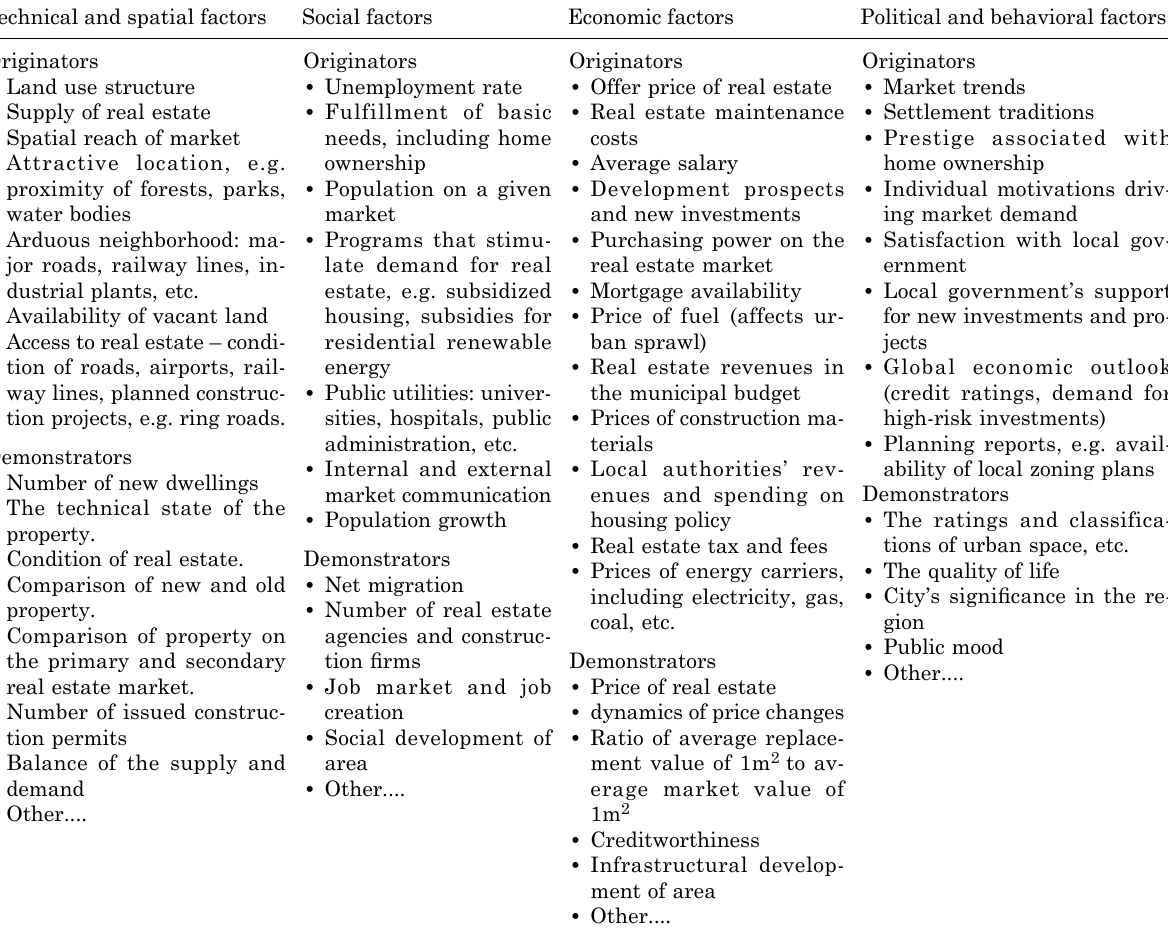
Table 1. Information base of the residential real estate market Technical and spatial factors